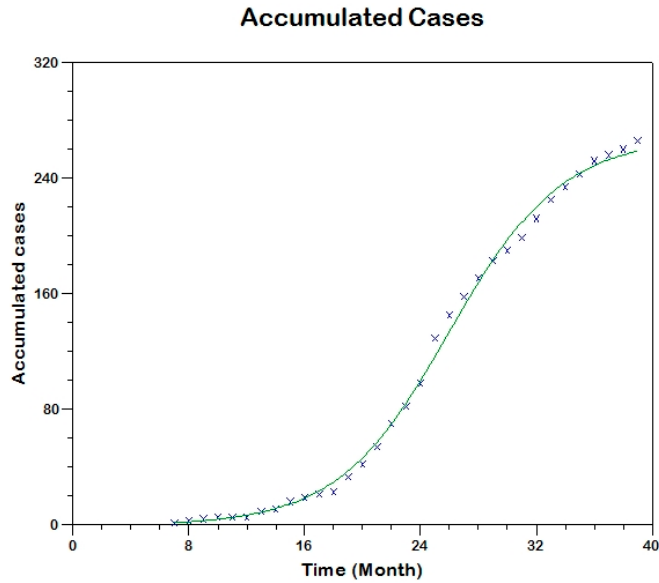
Figure 7. Model fit to the cumulative reported incidence of Madrid-Spain outbreak using Method 0.